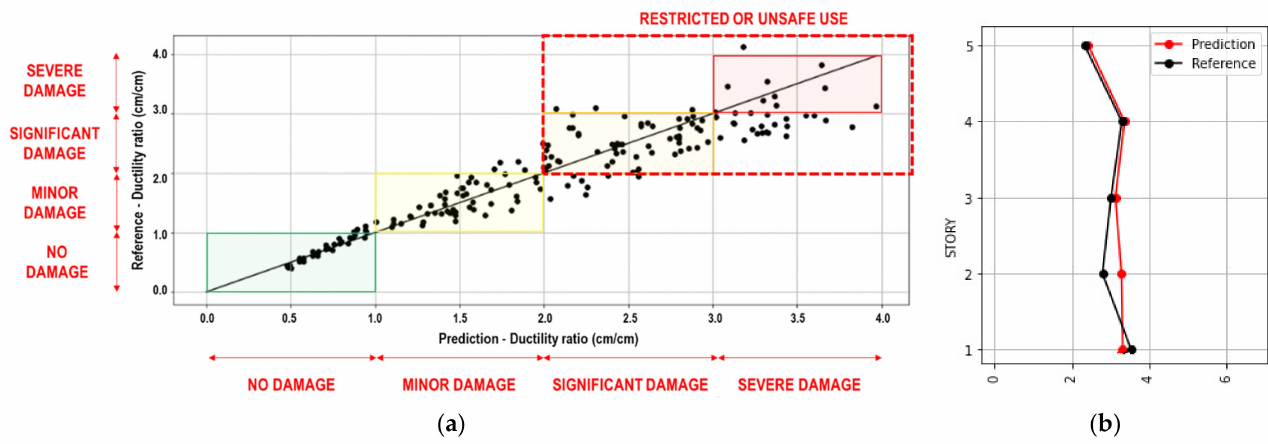
Figure 20. Example of the ductility ratio results (Petrolia California E–W record); ( a ) Comparison between prediction and reference values (points) and damage condition regions; ( b ) Prediction and reference ductility ratio of each story for a scale factor that produces Sa(T 1 ) = 900